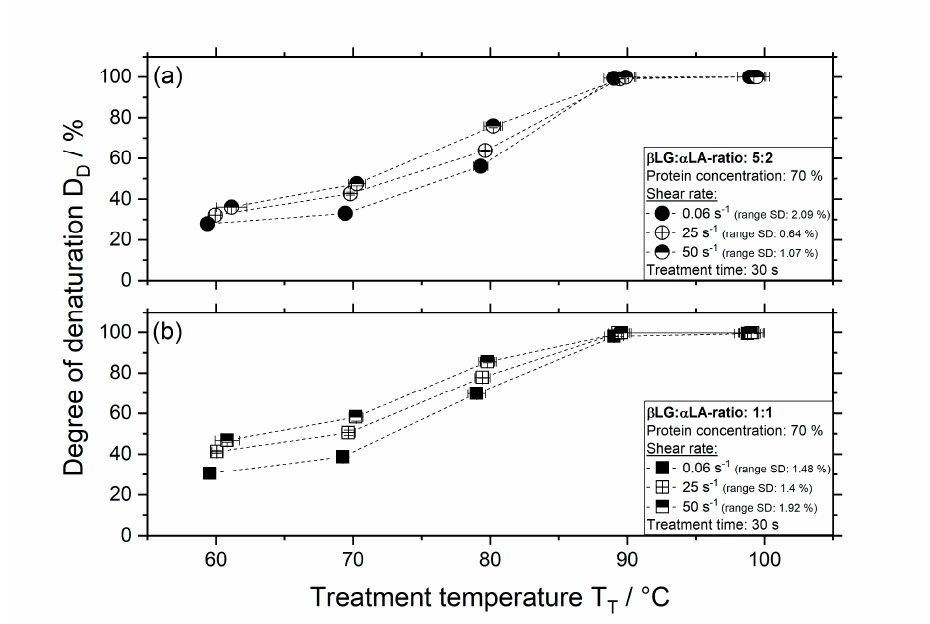
Figure 5. Degree of denaturation as a function of temperature and shear rate for 5:2 systems ( a ) and 1:1 systems ( b ) with a protein concentration of 70% ( w/w ) and treatment time of 30 s, bars represent standard deviation (SD). The range of SD for the treatment temperature was for all measurements ≤ 1.1%.